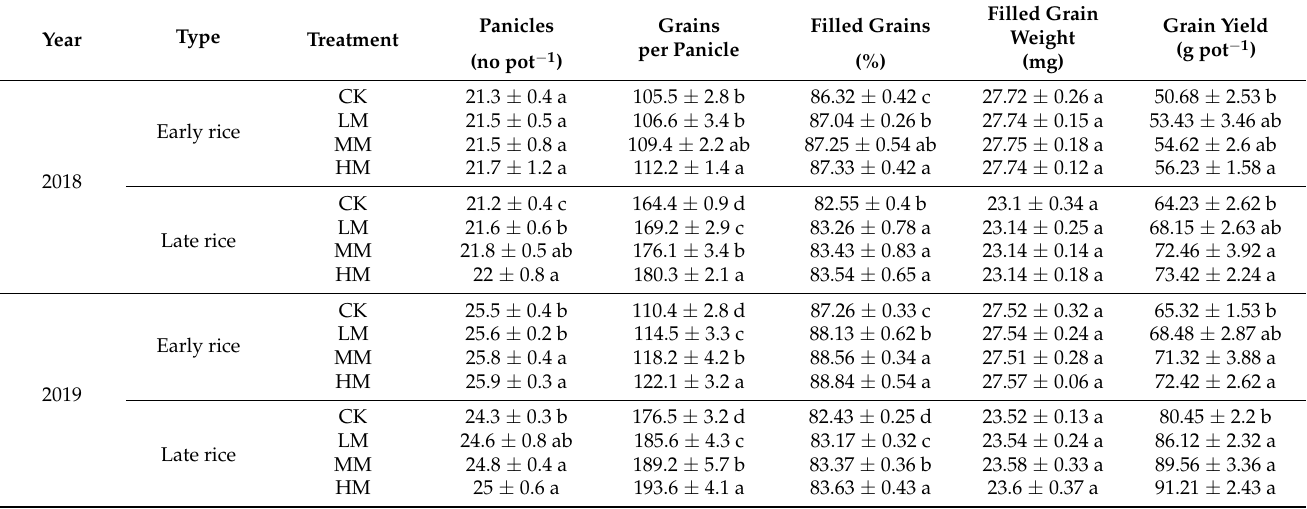
Table 1. Grain yield and yield components of the double cropping rice under different